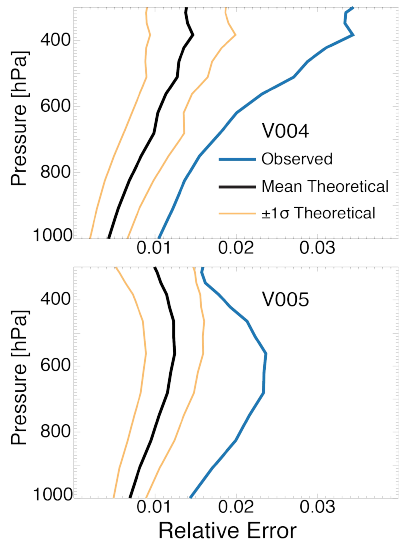
and theoretical relative errors. Blue lines represent the relative stan- dard deviation of ˆ z −ˆ z H . Black and yellow lines represent the mean and standard deviation of the diagonals of the TES observation error covariance